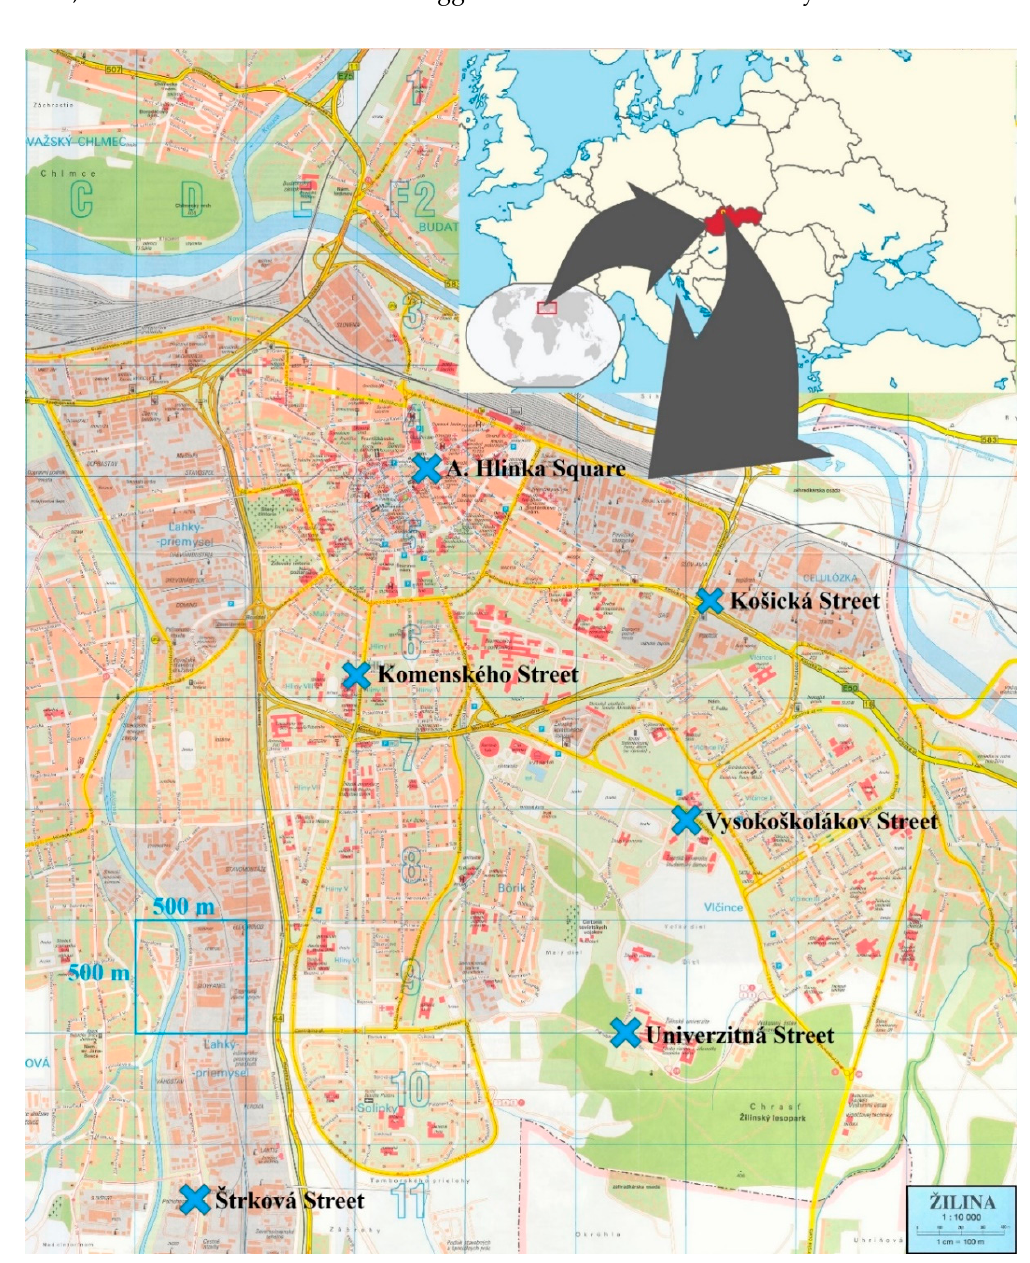
Figure 1. Location of measurement stations in Žilina city, Slovakia.